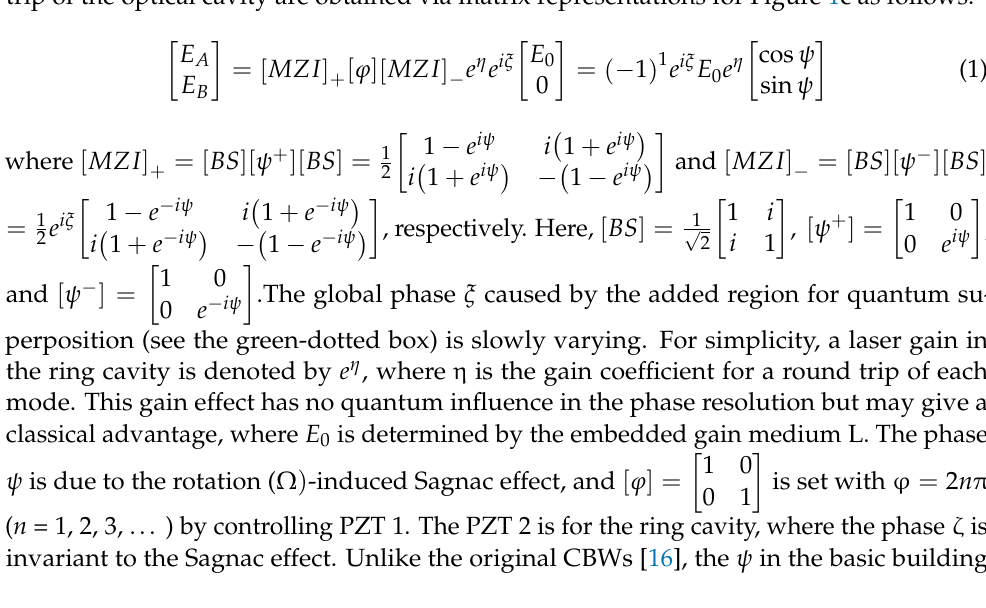
Figure 3. Numerical calculations for noise effects. ( a ) Cavity effects of Finesse. ( b ) Random phase noise-effect. ( c ) Gain effect (classical approach).